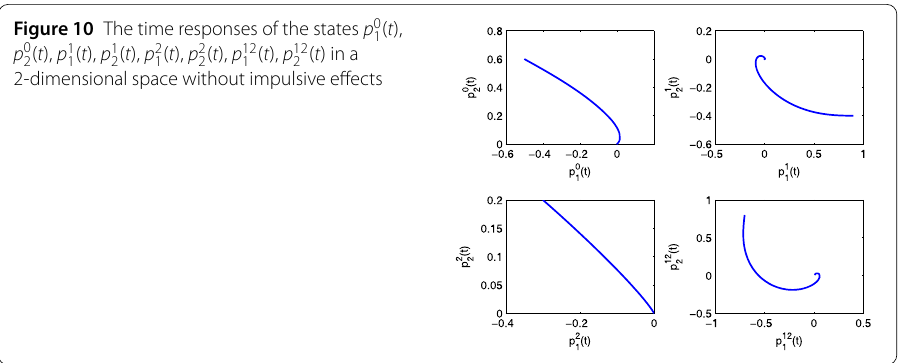
Figure 10 The time responses of the states p 0 1 ( t ), p